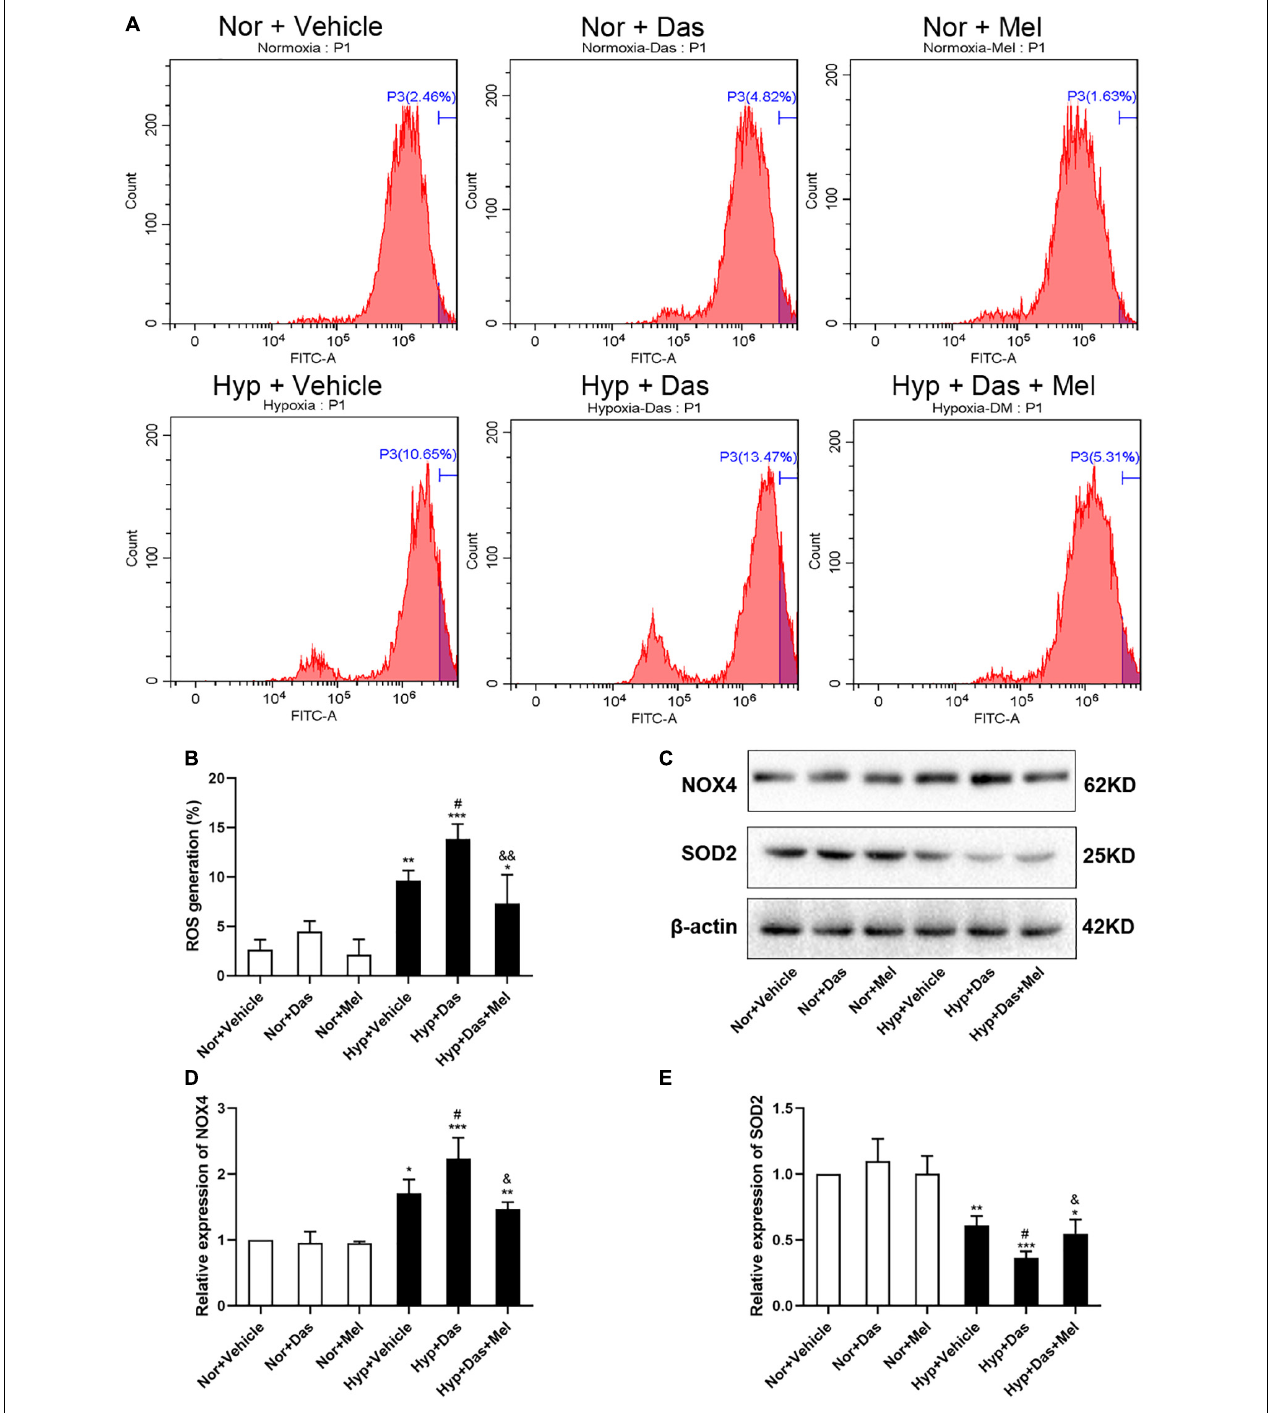
FIGURE 7 | Melatonin protects HPMECs from dasatinib-induced oxidative injury under hypoxia. Level of intracellular ROS generation (A) . A summary of flow cytometry analyses of HPMECs stained with 2,7-dichlorodihydrofluorescein-diacetate (DCFH-DA) (B) . Protein expression of NOX4 and SOD2 in HPMECs (C) . Bar graph shows the statistic results of NOX4 and SOD2 protein levels (D,E) . Values are means ± SEM, ***P < 0.001, **P < 0.01, *P < 0.05 compared with Nor + Vehicle group. # P < 0.05 compared with Hyp + Vehicle group. && P < 0.01, & P < 0.05 compared with Hyp + Das group ( n = 3).